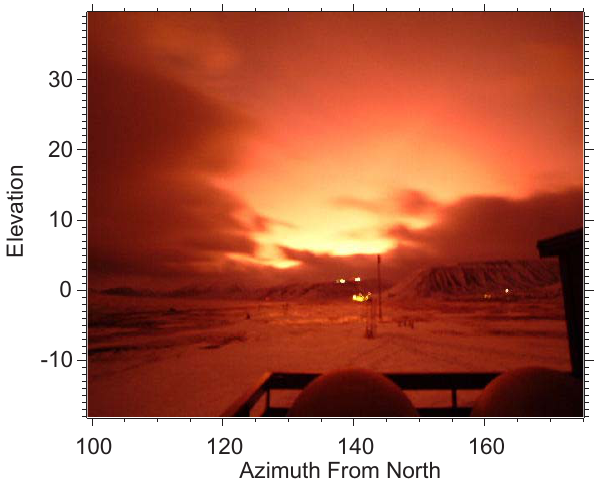
Fig. 1. Photograph of the red sky event taken at 08:42:41 UT with a Fujifilm S2Pro (4256 × 2848 pixels) digital camera using a 14mm lens, F2.8 aperture, 30s exposure and 1600 ISO. The field of view of the lens is specified in degrees.